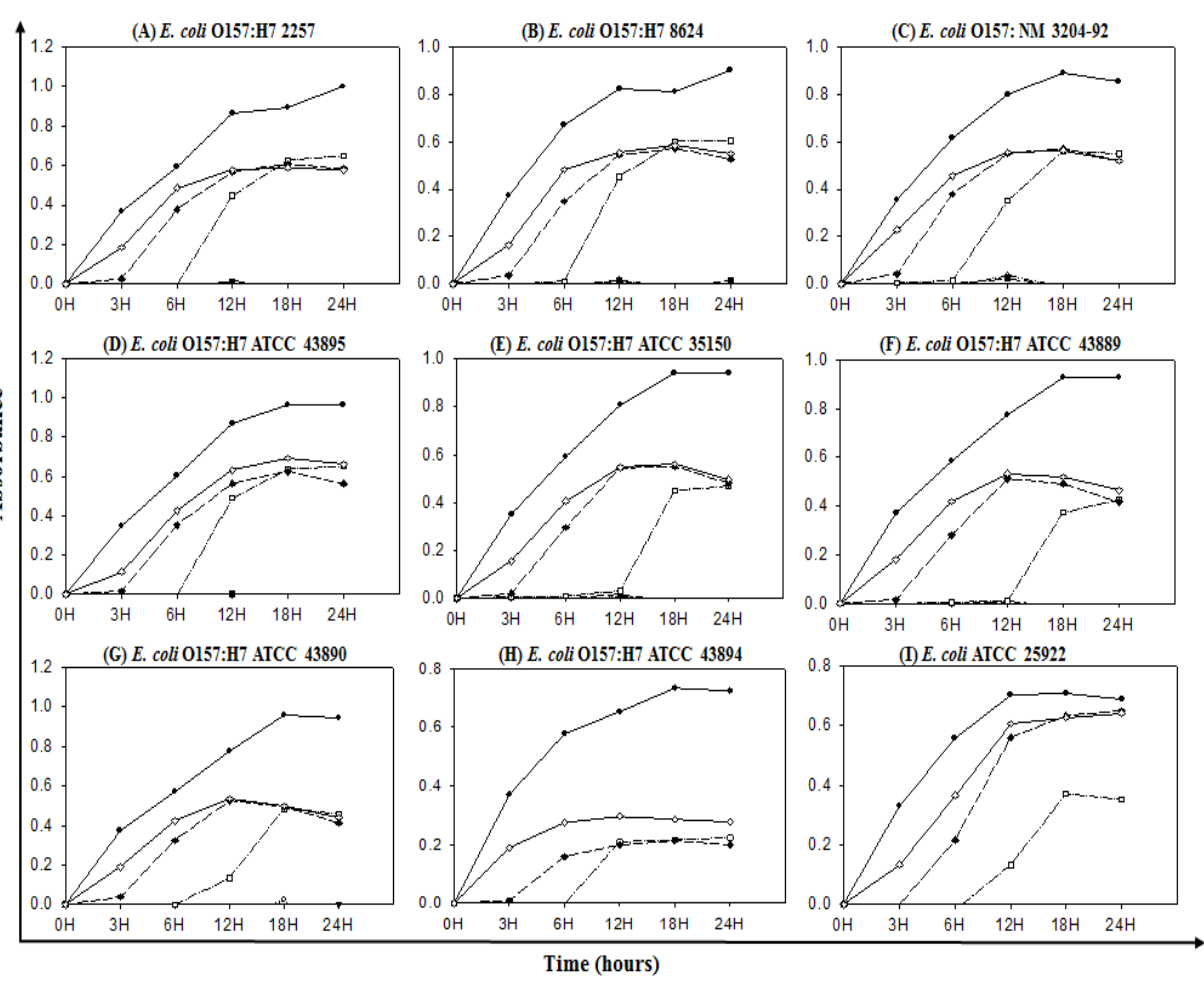
Figure 8. Growth curves of nine E. coli O157:H7 strains ( A – I ) cultured in LB broth with various concentrations of synthesized AgNPs to determine MIC. Control (●); 200 μg/mL (◦); 100 μg/mL ( ▼ ); 50 μg/mL ( △ ); 25 μg/mL (§); 12.5 μg/mL (□); 6.25 μg/mL (w); 3.12 μg/mL (◊ ). The MBC of synthesized AgNPs was 25 μg/mL for E. coli O157:H7 ATCC 43895, E. coli O157:H7 ATCC 35150, E. coli O157:H7 ATCC 43889, E. coli O157:H7 ATCC 43,890, and E. coli ATCC 25,922, and 50 μg/mL for E. coli O157:H7 2257, E. coli O157: NM 3204-92, E. coli O157:H7 8624 and E. coli O157:H7 ATCC 43,894 (Figure 9A – I).